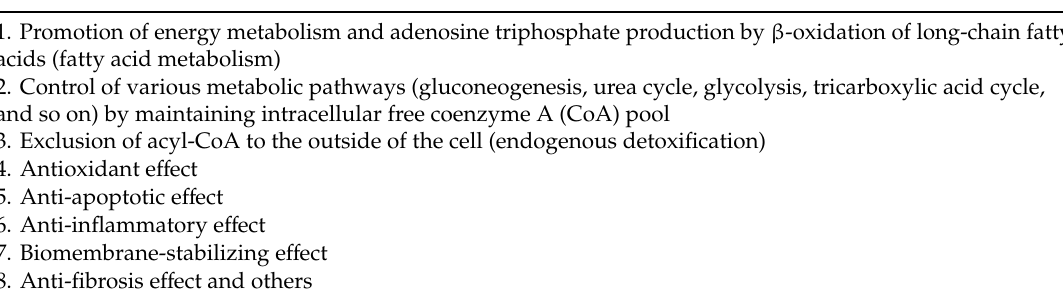
Table 1. Physiological function of carnitine.